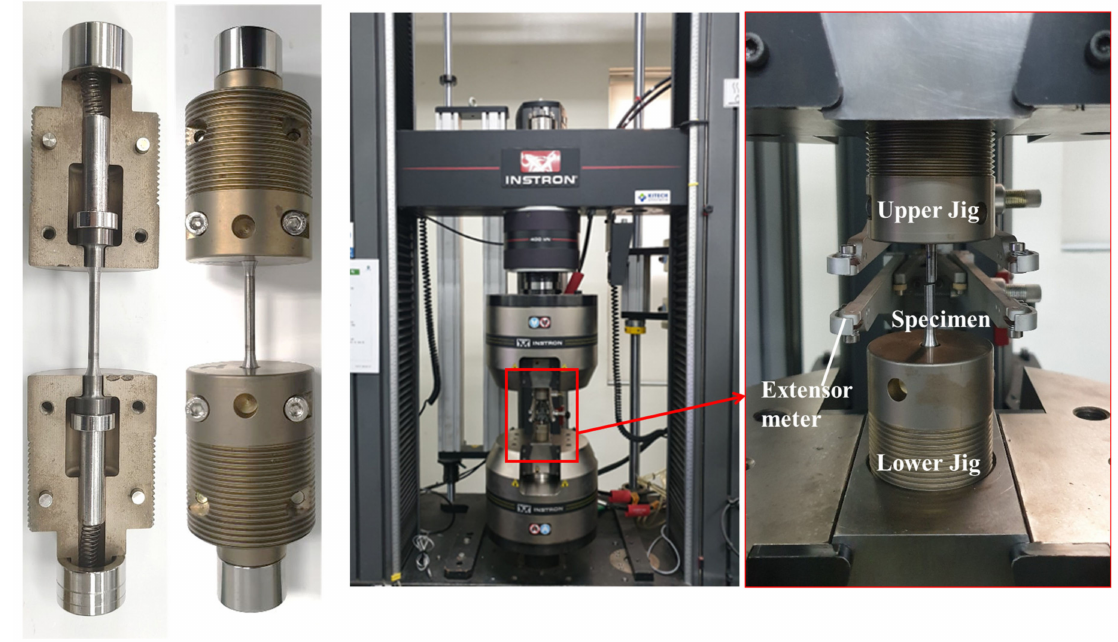
Figure 7. Manufactured jig and experimental setup for high-strength tensile tests.